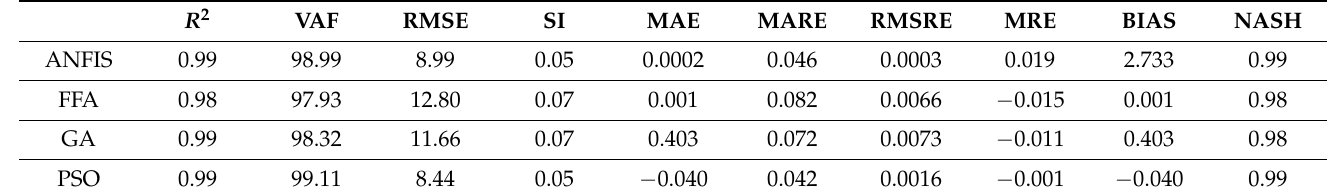
Table 4. Summary of model accuracy indicator test for the training data set (for the second combina- tion data set), which was calculated in Excel.